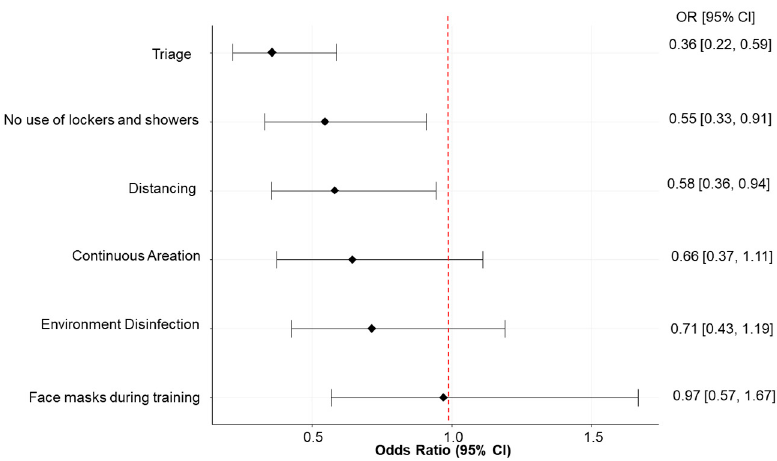
Figure 1. Odds ratio (OR) and 95% confidence intervals (CI) for the risk of being tested positive for SARS-CoV-2 according to the application of different preventive measures during sport activities. Note: triage consists in measuring fever and accounts for other symptoms and contact tracing.